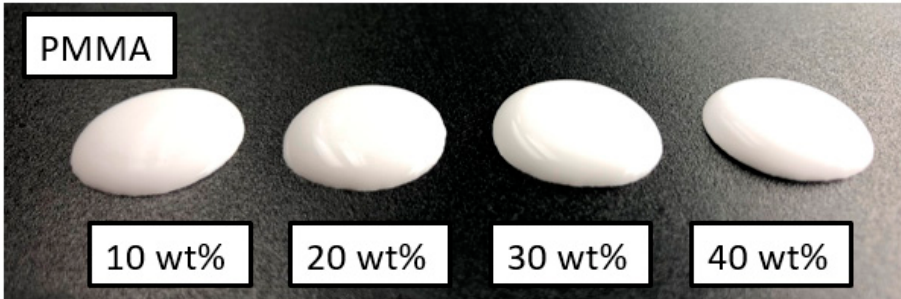
Figure 2. Slurries with 10, 20, 30 and 40 wt% PMMA after 60 min of magnetic stirring.